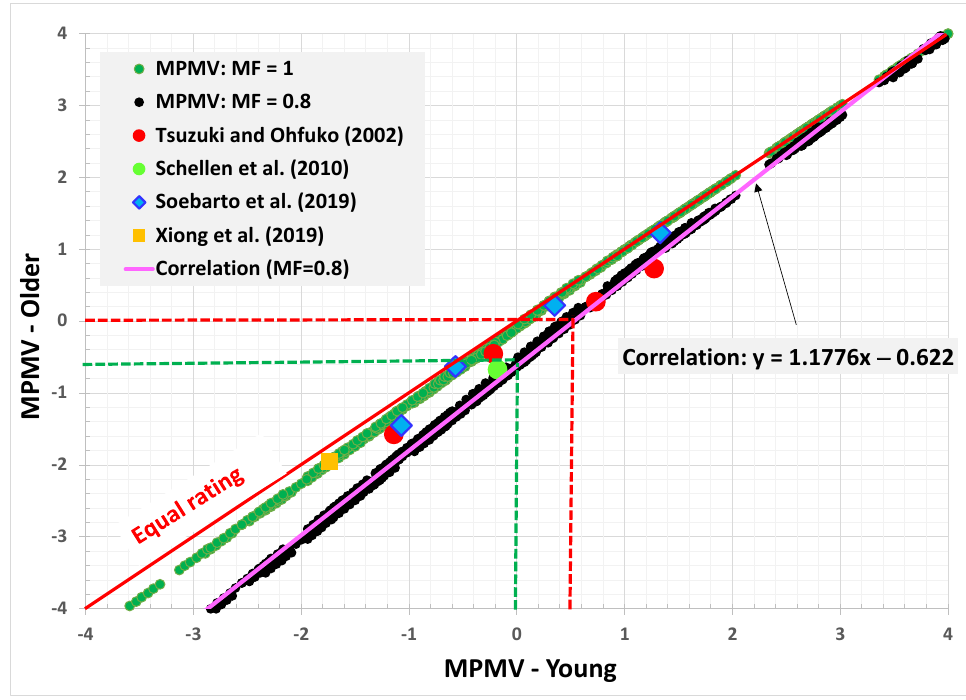
Figure 4. Comfort requirement of older people versus young adults and comparison with measured TSV data of. Tsuzuki and Ohfuko [44], Schellen et al. [48], Soebarto et al. [63], and Xiong et al. [64].